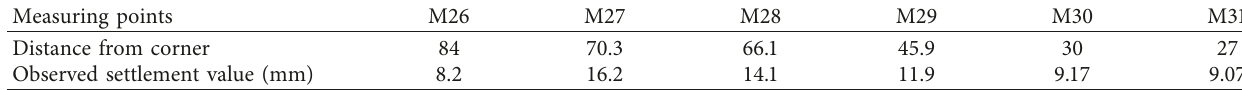
Table 5: Observed soil surface settlements at measuring points of Wulin Road excavation.